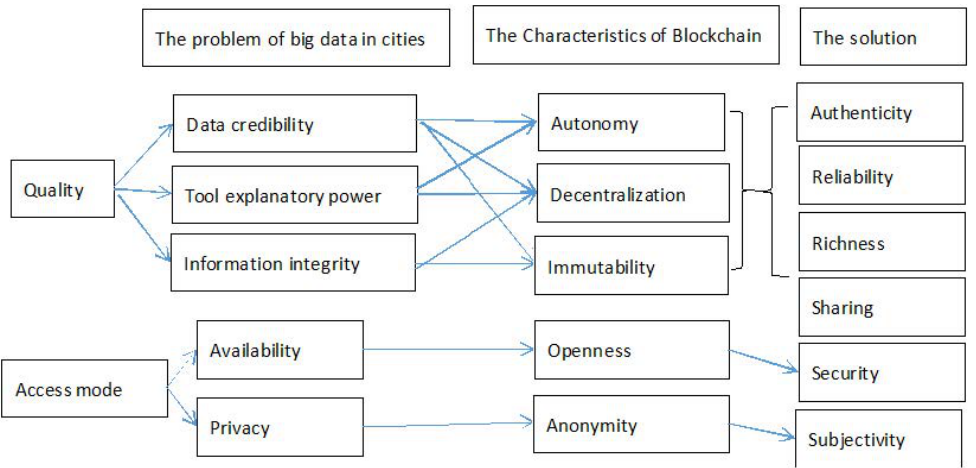
Fig. 1 Urban big data problems and blockchain